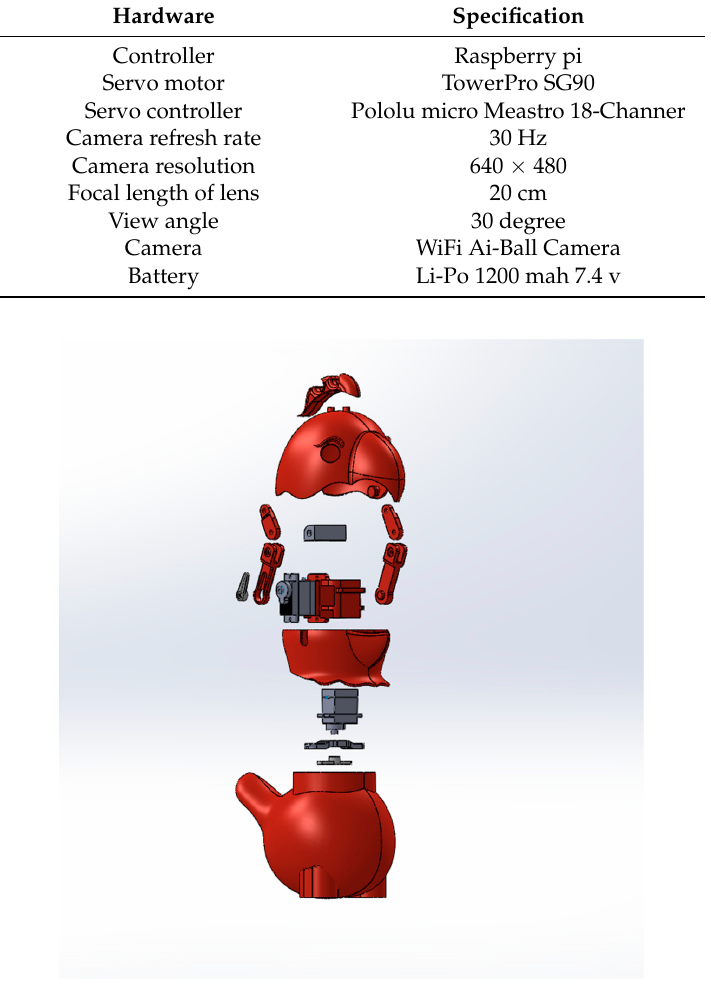
Figure 1 . Wearable KiliRo robot—exploded view.